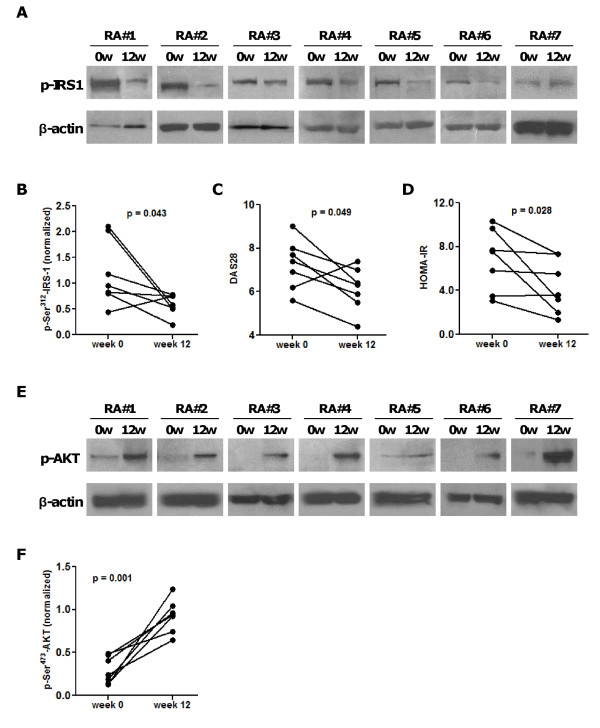
Anti-TNF treatment decreases insulin receptor substrate (IRS)-1 Ser312 phosphorylation and increases AKT phosphorylation in patients with active rheumatoid arthritis (RA) and high insulin resistance. (A) Seven patients with active RA received anti-TNF treatment for 12 weeks. Protein extracts from PBMCs were analyzed by western blotting for the Ser312-phosphorylated form of IRS-1 at weeks 0 and 12 of treatment. All but one patient demonstrated decrease in IRS-1 phosphorylation at Ser312. (B) Quantitative analysis (protein densitometry) showed that median phosphorylated IRS-1 normalized for β-actin levels were reduced from 0.96 to 0.57 (arbitrary units) (Wilcoxon signed ranks test, P = 0.043). (C) Decrease in disease activity following anti-TNF treatment (from median DAS28 7.4 to 6.3, P = 0.049). (D) Improvement in insulin resistance following anti-TNF treatment (from median HOMA-IR 7.6 to 3.6, P = 0.028). (E) Protein extracts from peripheral blood mononuclear cells (n = 7 RA patients) were analyzed by western blotting for Ser473- phosphorylated AKT at weeks 0 and 12 of anti-TNF therapy. (F) Phosphorylated AKT levels, normalized for β-actin, increased in all RA patients from a median 0.24 (arbitrary units) at week 0 to 0.94 at week 12 (P = 0.001).